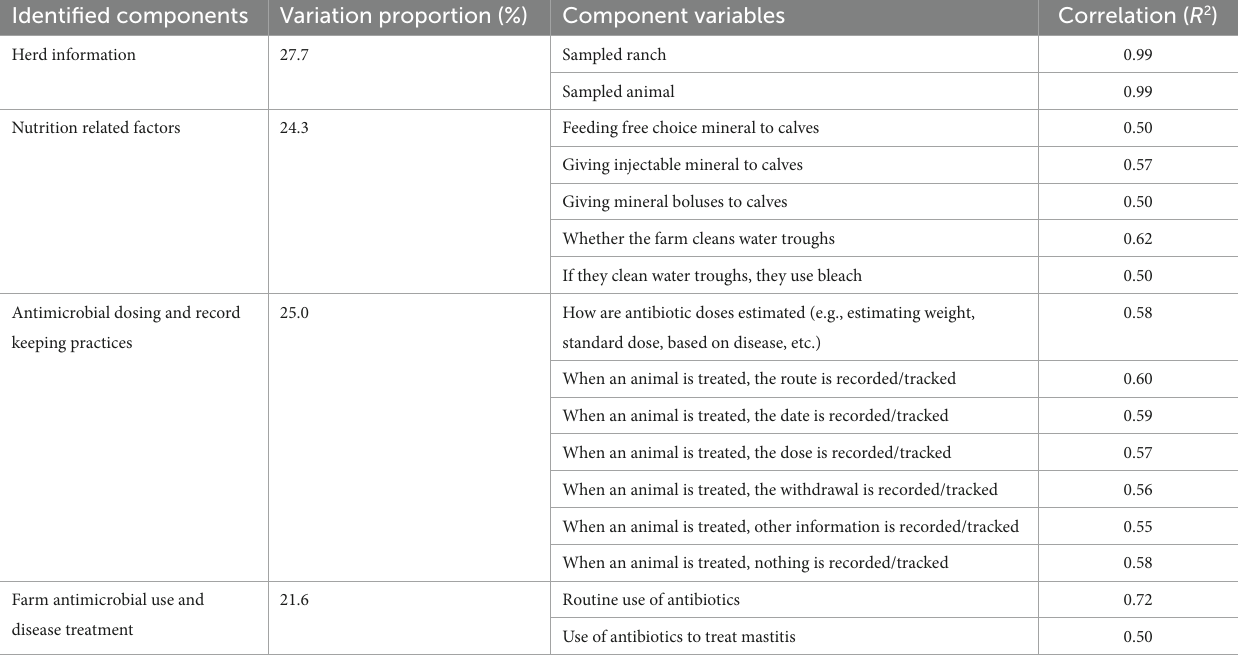
TABLE 5 Multiple factor analysis (MFA) of 63 data variables collected in a cross-sectional study evaluating antimicrobial resistance status, management factors, and antimicrobial drug use in 18 cow-calf operations in northern California between July 2019 and August 2020. The MFA identified four groups (components) and 16 variables with a correlation coefficient ≥ 0.5 on both first and second dimensions that contribute the most (98.6%) to the variation in the data set. Identified